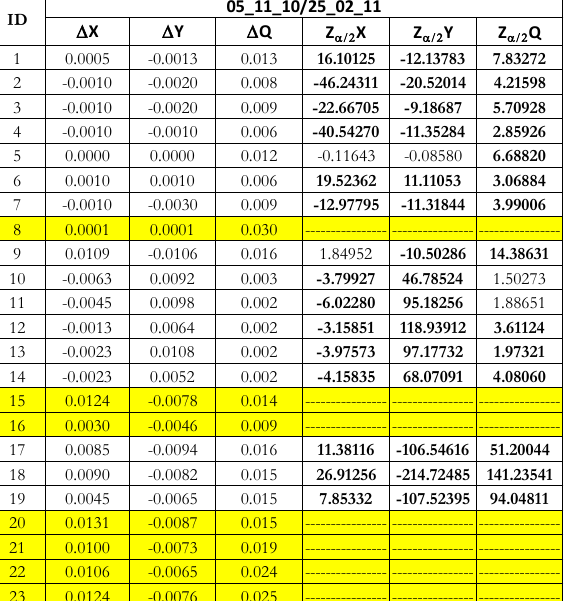
Table 6. Differences of adjusted coordinates and